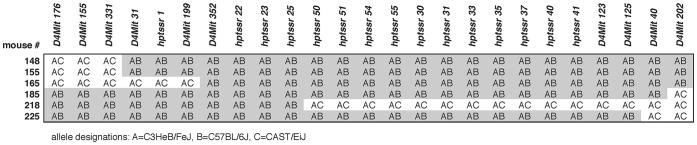
High resolution mapping of the Hpt mutation.Fine mapping of the Hpt mutation by segregation analysis of the HPT/LeJ-Hpt/+ x CAST/EiJ) F1 hybrid x C3HeB/FeJ cross. All of the 182 N2 offspring typed for the Chromosome 4 markers had one allele derived from C3HeB/FeJ (A) and the other allele derived from either C57BL/6J (B) or CAST/EiJ (C). Shown are the AB (gray) and AC (white) genotypes of 25 markers in the six most informative mutant N2 mice (Hpt/+, genotype designation AB) recombinant between D4Mit176 and D4Mit202. The markers D4Mit 352, hptssr22, hptssr23, and hptssr25 are non-recombinant with the Hpt mutation in all six mice, and the new flanking markers D4Mit 199 and hptssr50 refine the candidate gene interval to a 6.7 Mb region.